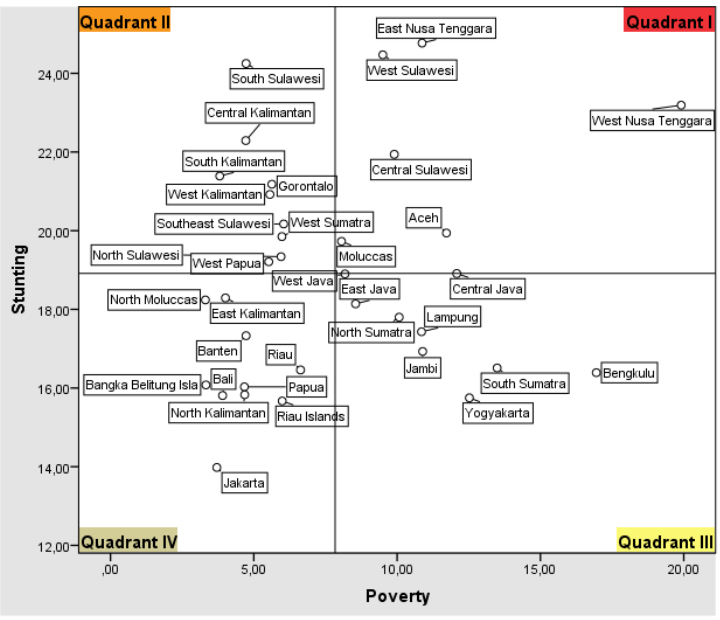
Figure 5: Classification of Percentage Poor People and Prevalence of Stunting in 34 Provinc- es in Indonesia, 2010-2018